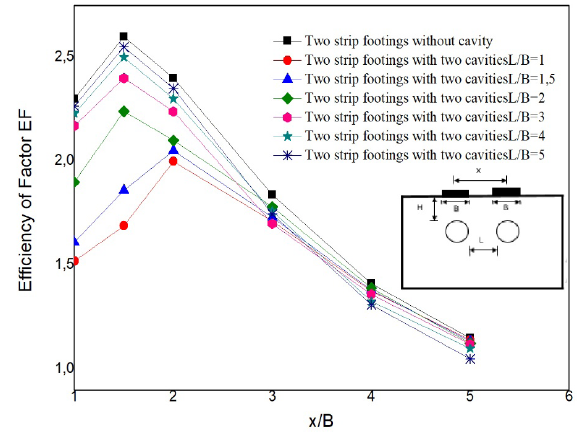
Figure 11: Variation of EF as a function of x/B in the following cases: two strip footings without cavity and with cavity (H/B = 2); (L/B = 1.0, L/B = 1.5, L/B = 2.0, L/B = 3.0, L/B = 4.0, L/B = 5.0).